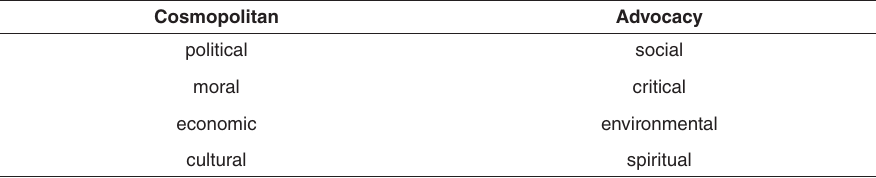
Table 1: Categories of global